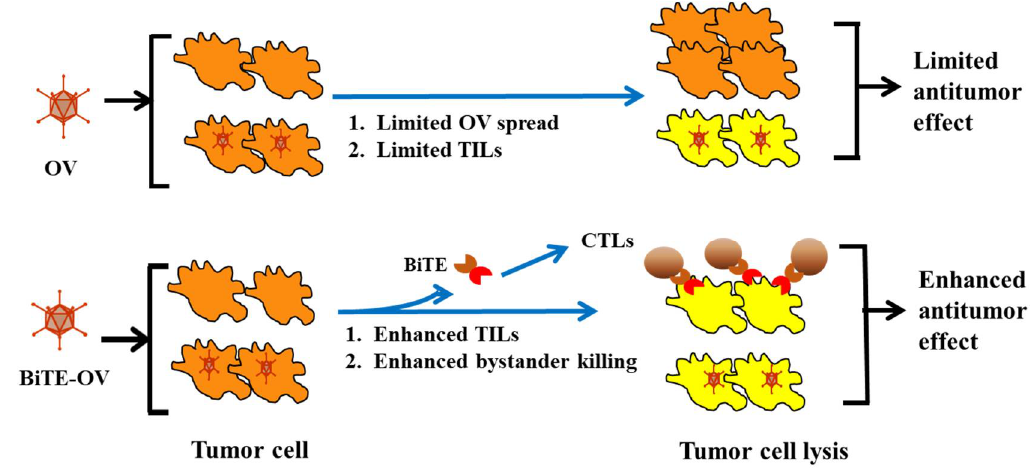
Figure 3. Working mechanisms of a BiTE-armed oncolytic virus (OV). The efficacy of a “pure” OV is often limited by suboptimal spread of the OV throughout the tumor tissue and induction of tumor antigen-specific T cells. BiTE-armed OV may overcome these limitations as the armed OV produces and secrete these BiTEs that diffuse within the tumor tissue, activating and directing endogenous T cells to recognize and kill the tumor cells or/and stromal cells effectively (even if not directly infected by the OV), resulting in improved antitumor efficacy. This is a modified version of a figure originally published by Song XT, Discovery Med, 2013 [71]. Table 1. Representative BiTE- and TriTE-armed OVs for cancer immunotherapy.